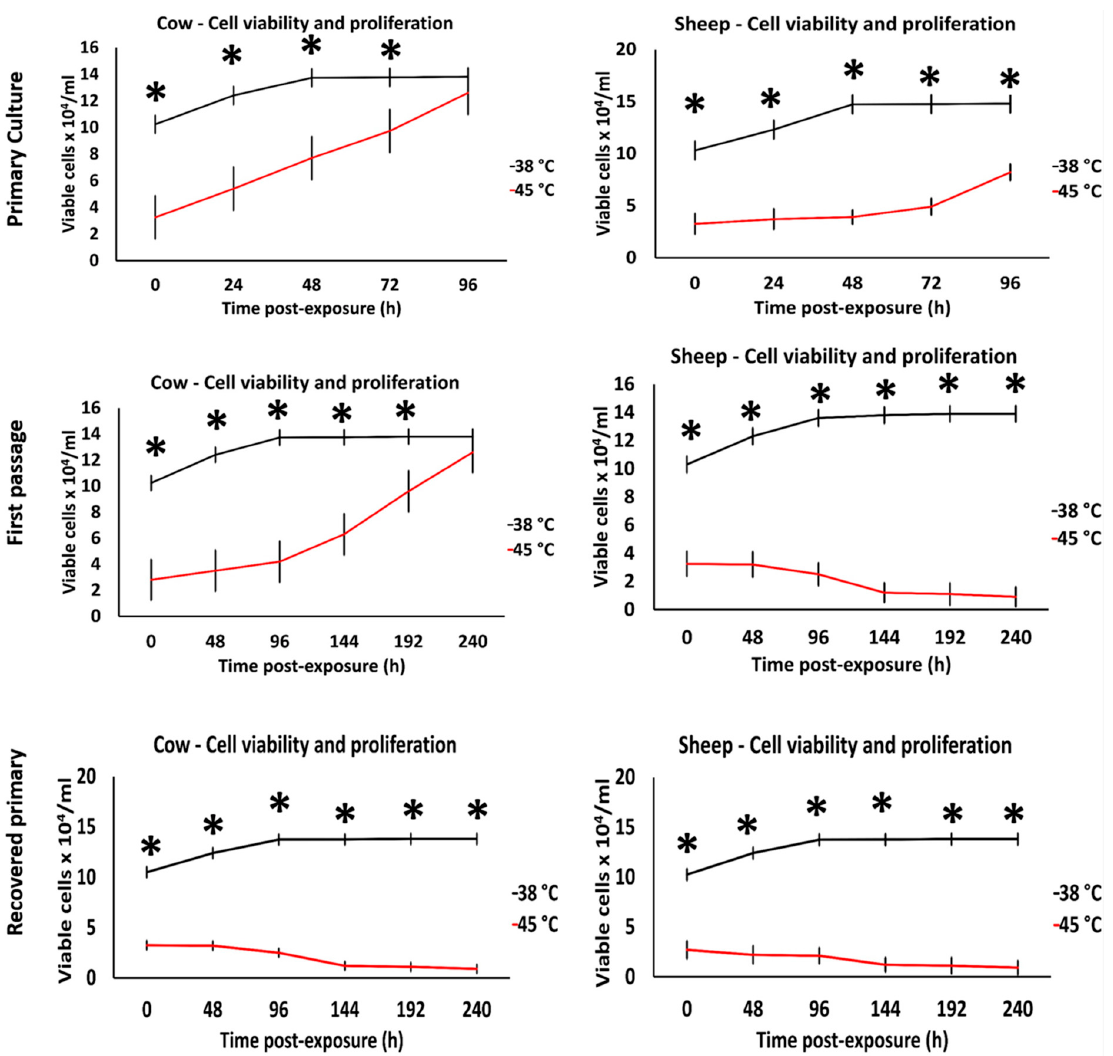
Figure 1. E ff ects of acute heat stress (45 ◦ C for 4 h) on cow and sheep cell viability. After the end of exposure (0 h), cells were recovered at 38 ◦ C in a humid atmosphere of 5% CO 2 and examined daily for cell viability until they reached 100% confluency (~13 × 10 4 cells / mL). Data are presented as means ± SEM, values of the same timings were analyzed using Student’s t -test, and asterisks (*) indicate significant di ff erences at p < 0.05.